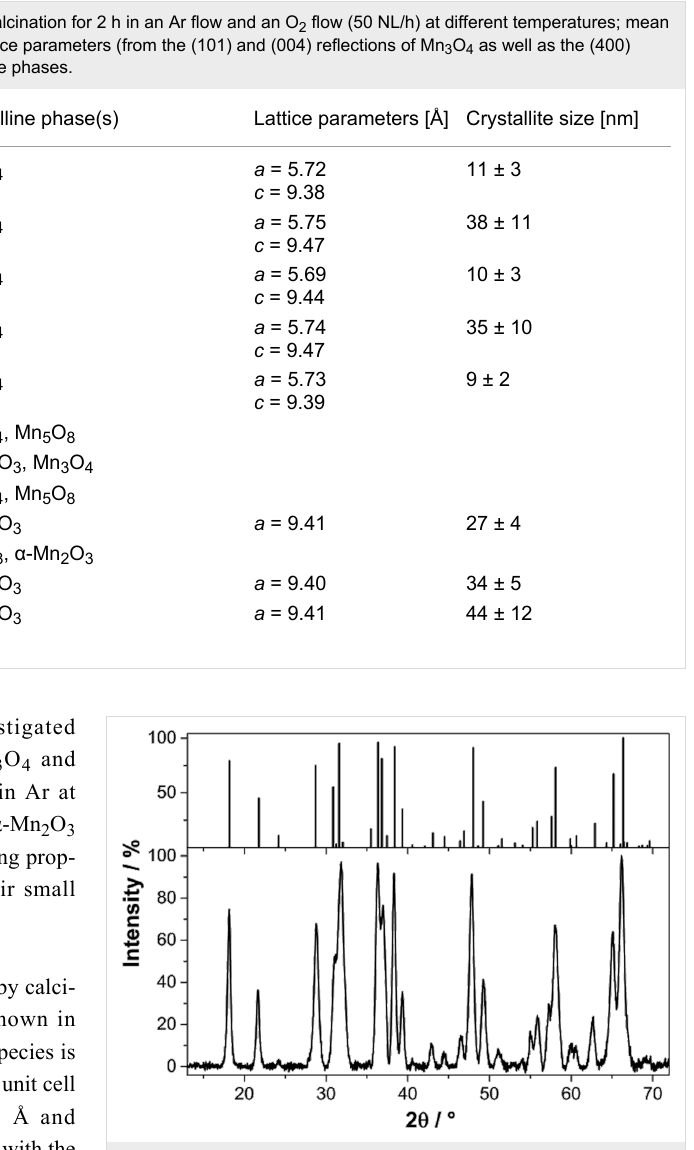
Figure 5: Powder XRD patterns of the Mn 5 O 8 particles obtained by calcination of Mn(II) glycolate for 5 h at 400 °C in an O 2 flow of 50 NL/h; a reference pattern is given in the top panel (ICDD 00-039-